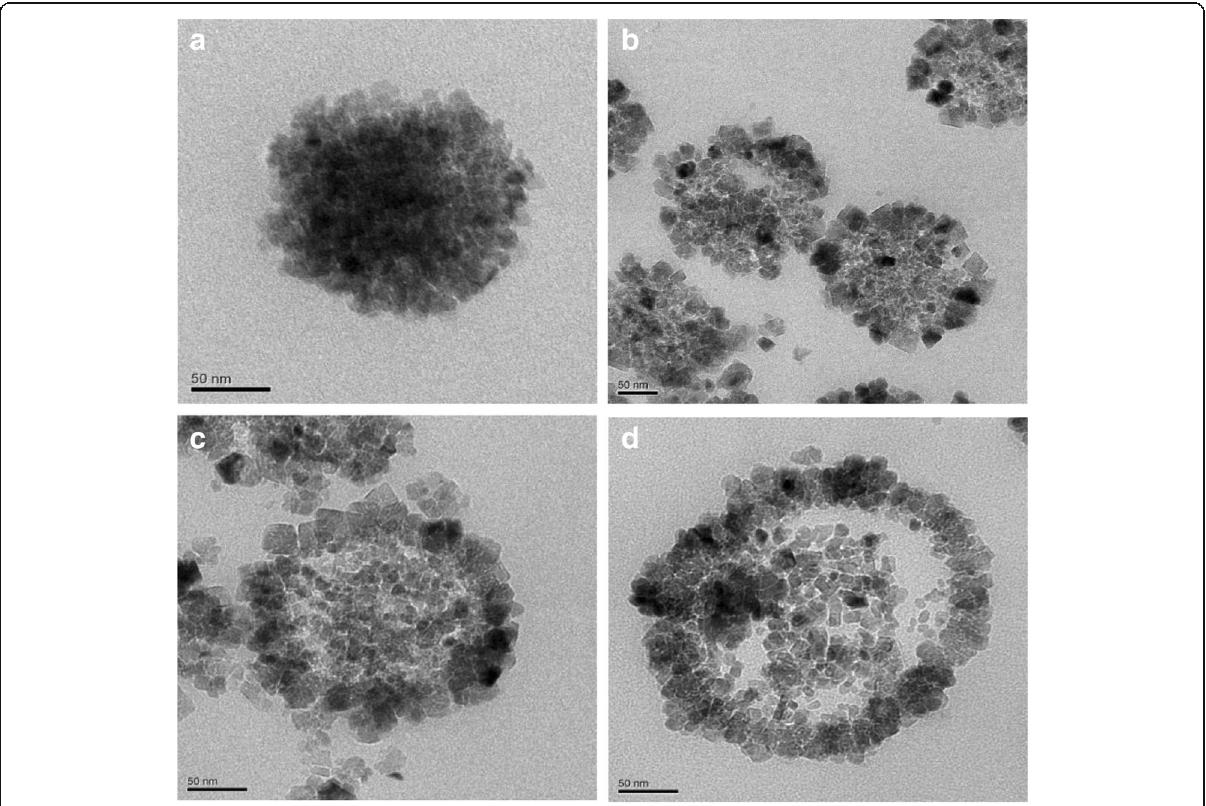
No. 79-06419). No obvious impurity peaks are found in Fig. 5. The sharp peak indicated the high crystallinity of products. It indicated that urea as alkali source in the reaction system did not affect the formation of Fe crystal grains. In the reaction process, urea was decom- posed to NH and provides an alkaline environment for 3 the solution system [22].